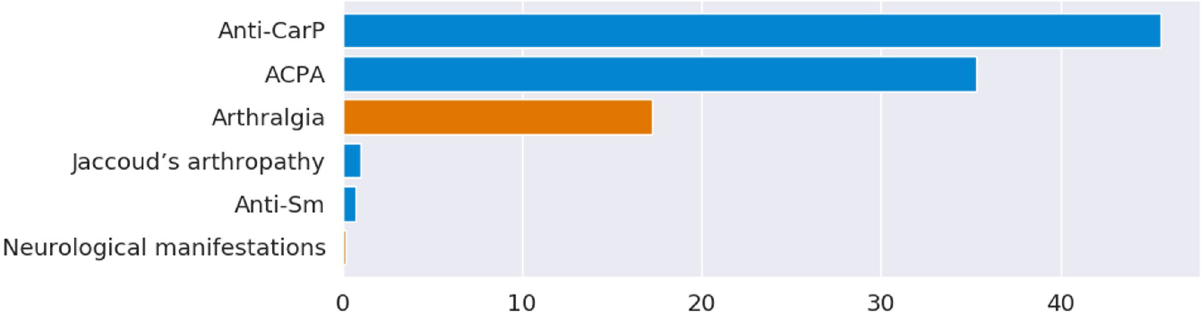
Fig 1. Relative importance (%) of the selected features. Blue colored ones are positively associated with the development of bone erosions while orange ones are negatively associated.